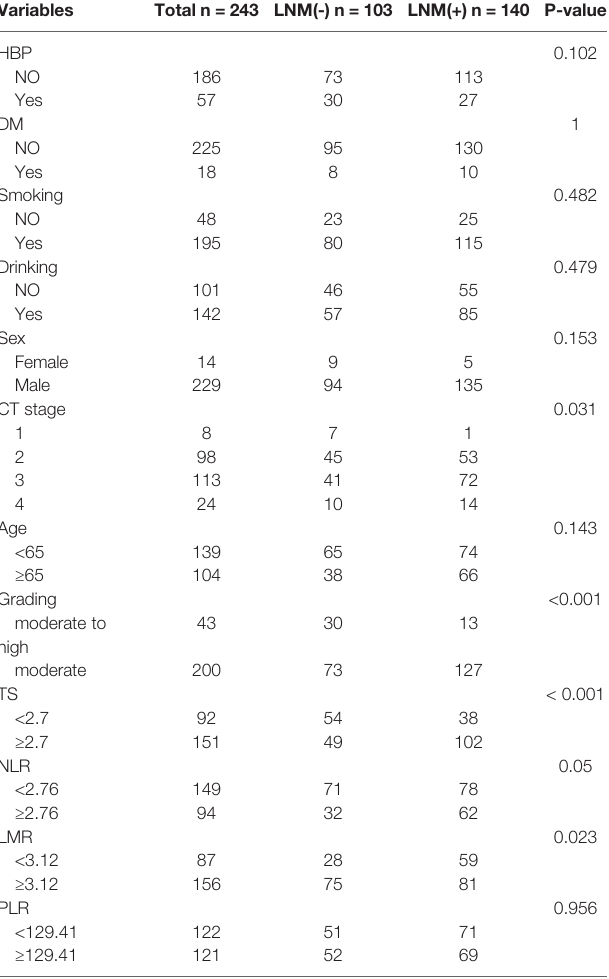
TABLE 2 | Relationship between lymph node metastasis and clinicopathologic variables in training set. Variables